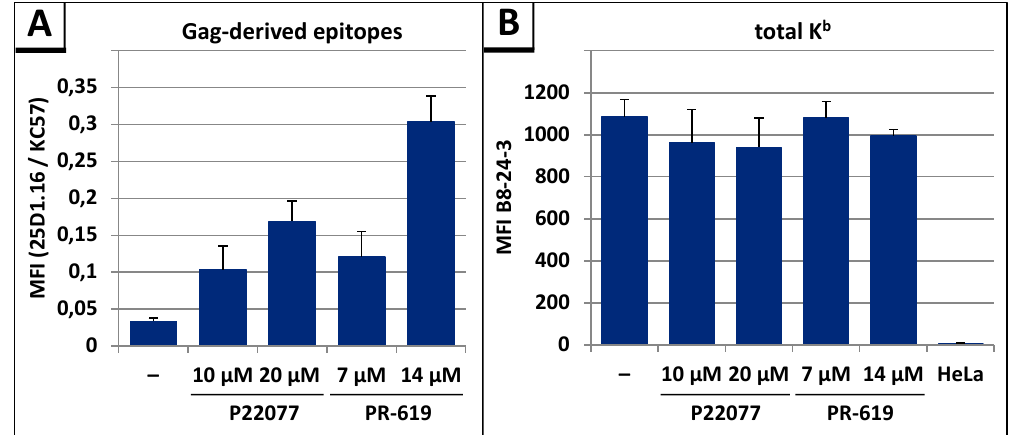
Figure 9. DIs P22077 and PR-619 increase antigen presentation of Gag-derived epitopes. HeLa-K b cells were transiently transfected with syngag-SL expression plasmids. Twenty-four hours post transfection cells were treated with indicated amounts of P22077 or PR-619 for 4 h. ( A ) H2-K b -SL complexes presented on the surface of Gag-positive cells were quantified by flow cytometry using the mAb 25D1.16-APC, intracellular Gag was stained with anti-Gag Ab KC57-FITC. The mean fluorescence intensity (MFI) of the 25D1.16 staining, normalized to the MFI of the intracellular anti-Gag staining is shown. Bars represent mean values of 3 independent experiments ± SD; ( B ) Total H2-K b was quantified by flow cytometry using hybridoma cell culture supernatant containing the mAb B8-24-3. HeLa cells devoid of H2-K b served as negative control. Bars represent mean values of 3 independent experiments ± SD.